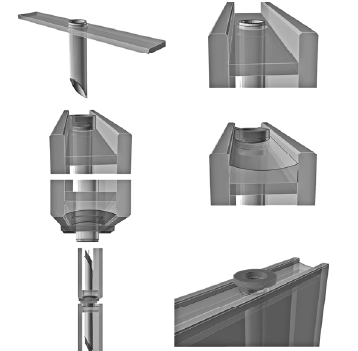
Figure 8: Detail of the tubes between the insulated glass